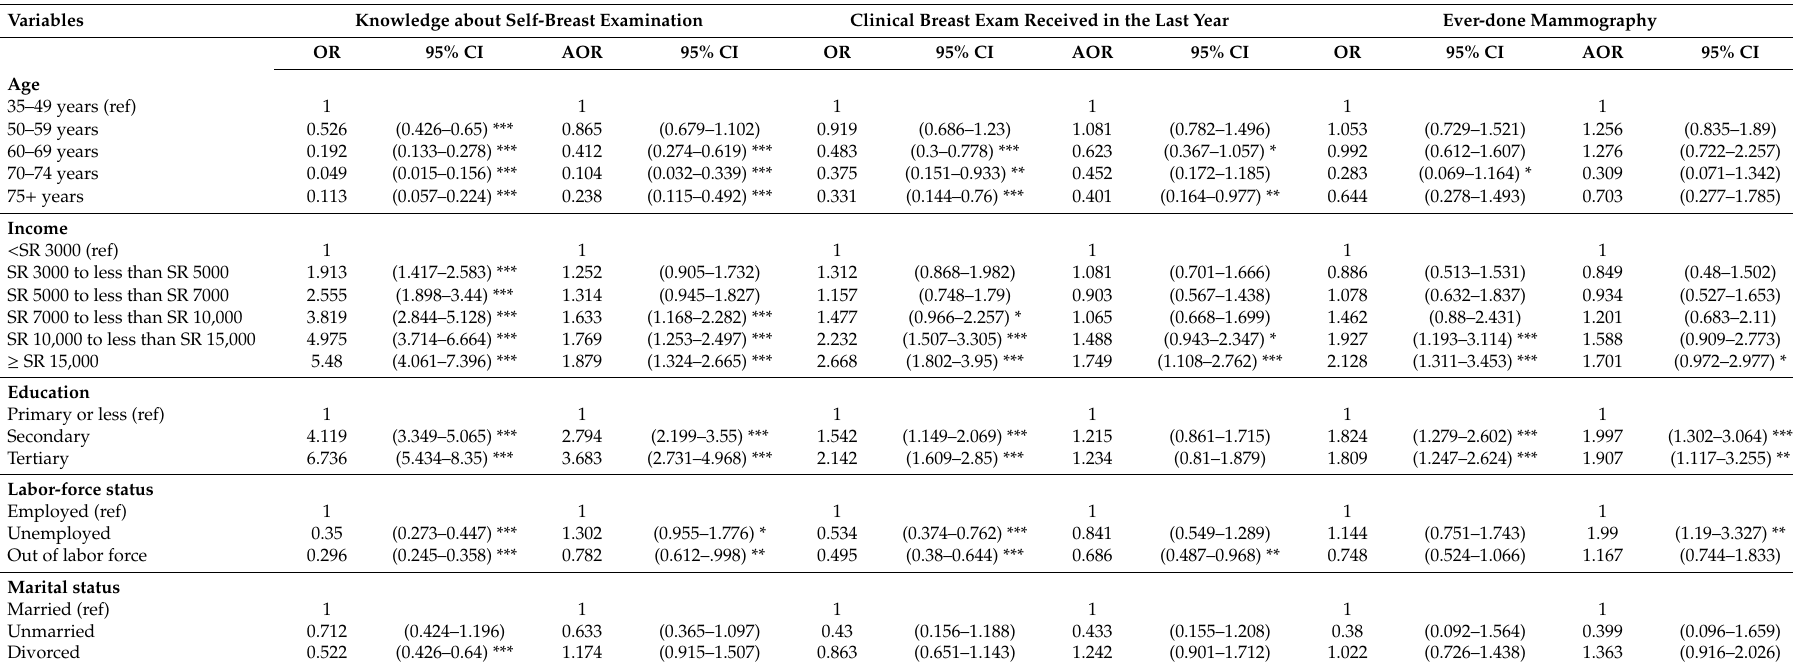
Table 5. Logistic regression results of the correlates of breast cancer screening